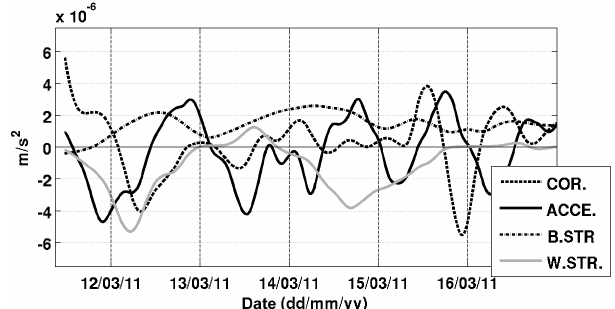
Figure 5. Estimates for the along-shelf momentum terms at 50m. Left-hand-side terms of Equation 1: acceleration terms (ACCE. δv/δt ) and Coriolis (COR. fu ). Right-hand-side terms of Equa- tion 1: wind stress term (W.STR. τ ys /ρH ) and bottom stress term (B.STR. – τ yb /ρH ). The data used for estimating the momentum terms have been low-pass filtered with a cutoff period of 12h. The date indicates